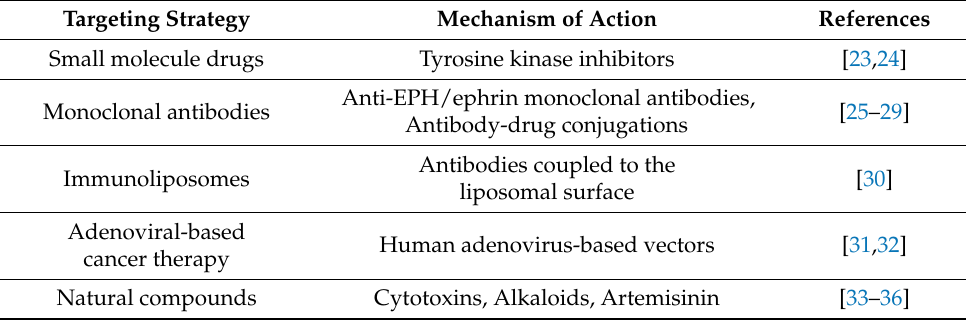
Table 1. Main available therapeutics targeting the EPH/ephrin system in